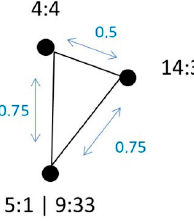
Figure 2. Visual rendition of the distances in the sample dissimilarity matrix in Table 4. Figure 2 is a visual rendition of the distances in the dissimilarity matrix in Table 4.